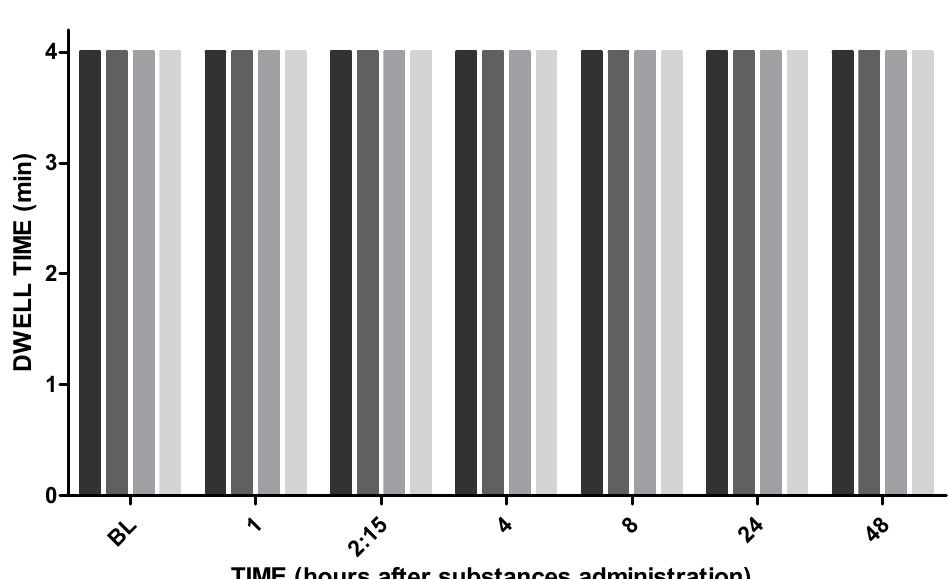
Figure 13. Motor coordination and balance evaluation. Legend: Pregabalin: PG (10 mg/kg, Orally); WATER: vehicle of PG; PN: polymeric nanocomposite; PG-PN: PG-loaded polymeric nanocomposite (10 mg PG/kg, Orally); EMP-PN: polymeric nanocomposite without PG (vehicle of PG-PN); BL: baseline latency; experimental time: 48 h. A two-way ANOVA test with repeated measures with Newman–Keuls post-test was applied for comparison between the different groups. No significant difference was observed. Each bar represents the mean ± standard error of the mean (±S.E.M.) of six animals.